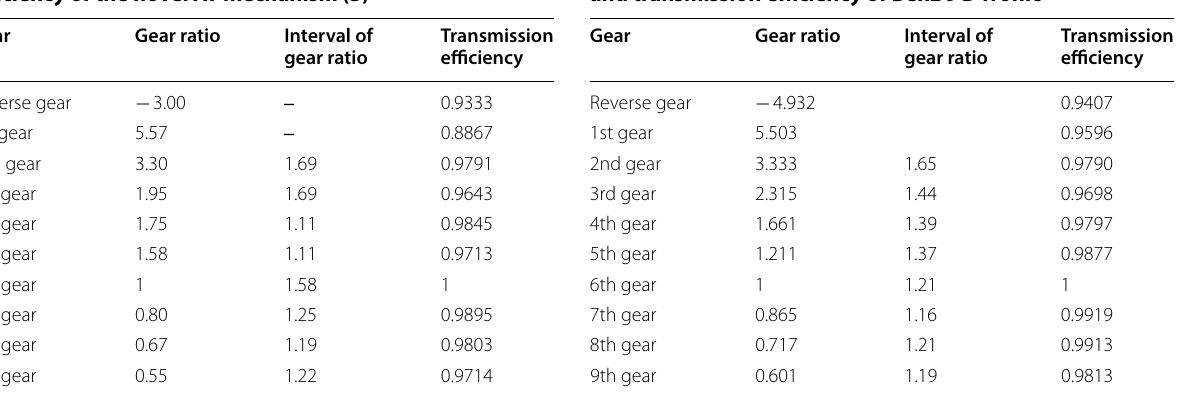
Table 9 Gear ratios, interval of gear ratio and